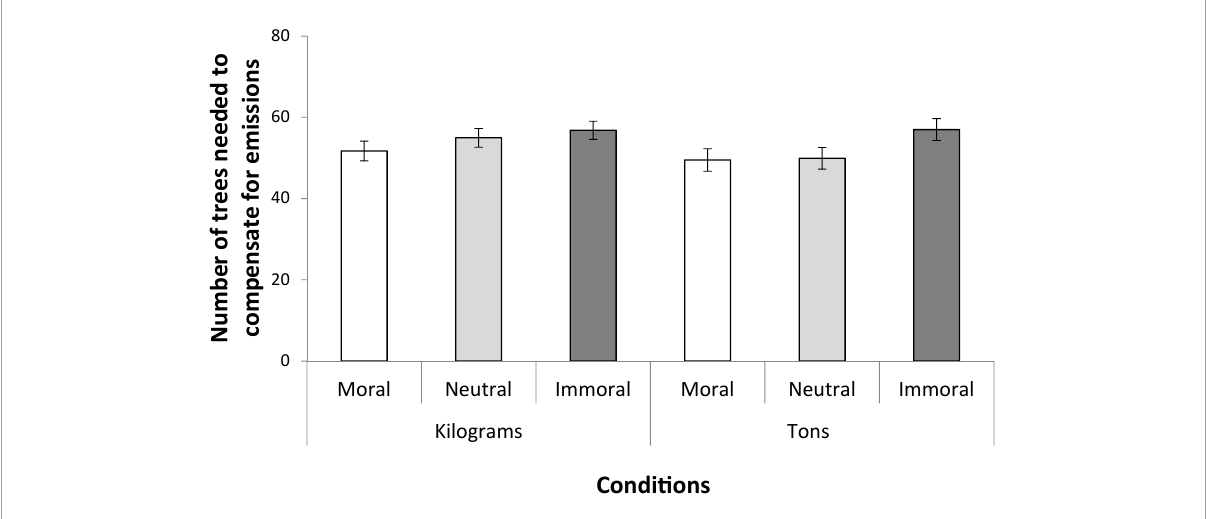
FIGURE2 Mean estimates of how many trees needed to compensate for the emissions (stated in either kilograms or tons) from trips. Either the trips had a moral, neutral, or an immoral reason. Only the moral reason main effect was significant, and there were no significant interactions. Error bars represent the standard error of the